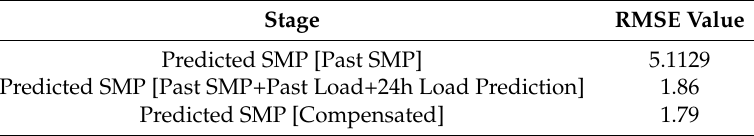
Figure 15. Summer SMP prediction 1–3. Table 10. RMSE value for summer data.